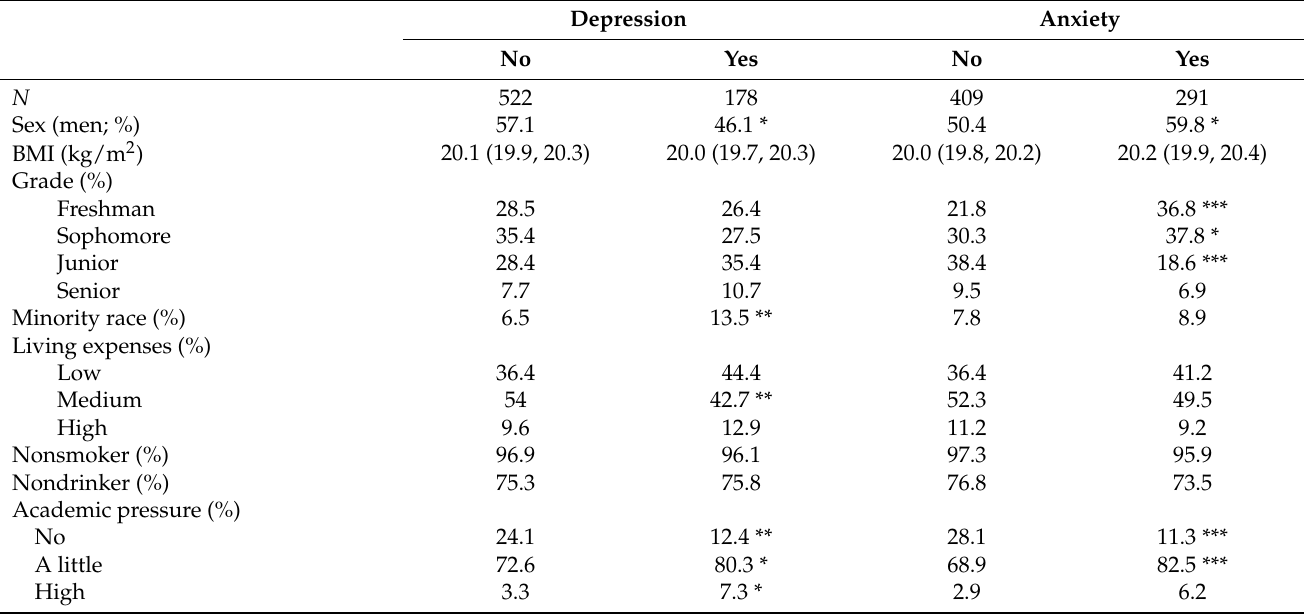
Table 1. Basic characteristics of participants according to mental